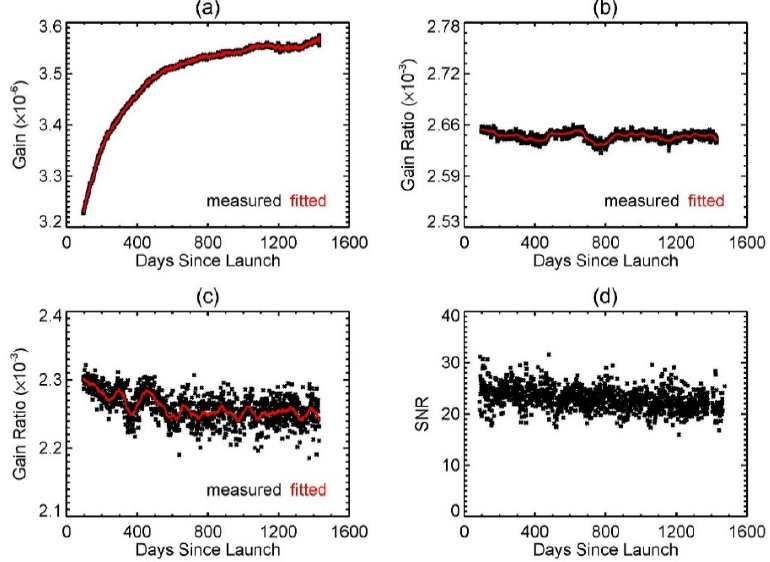
Figure 7. ( a ) DNB low gain stage (LGS) gain; ( b ) mid-gain stage (MGS)/LGS gain ratio; ( c ) high gain stage A (HGA)/MGS gain ratio and ( d ) HGA SNR trended for detector 8, aggregation mode 5, HAM side A over the entire mission. Fits of the LGS gains and gain ratios are shown by the red curves.